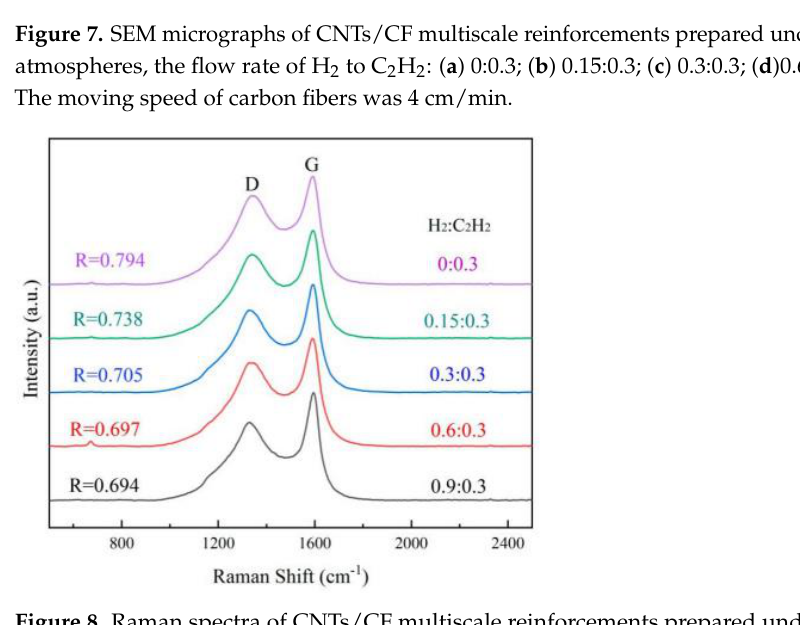
Figure 8. Raman spectra of CNTs/CF multiscale reinforcements prepared under different growth atmospheres. The moving speed of carbon fibers was 4 cm/min.